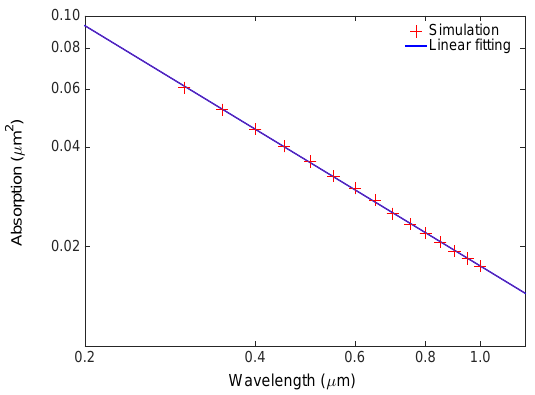
Figure 5. Absorption cross sections of fresh BC with a wavelength- independent refractive index of 1.8 + 0.6 i and a GMD of 0.12µm as a function of